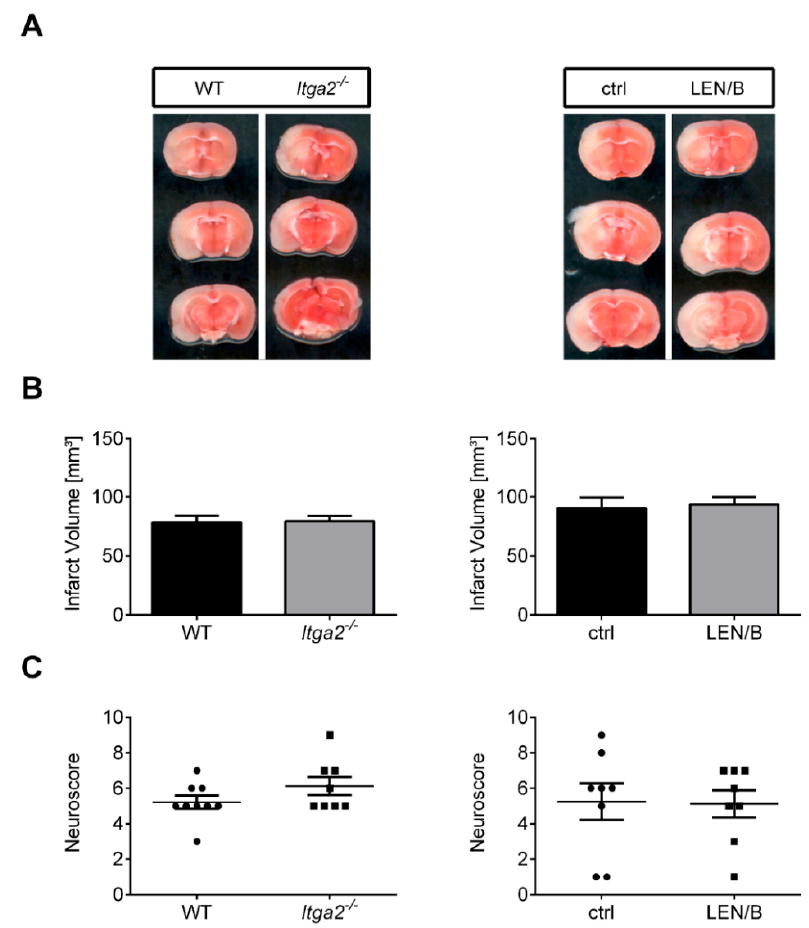
Figure 1. Therapeutic blockade or genetic deficiency of the collagen-binding integrin α 2 β 1 does not alter stroke outcome in a transient middle cerebral artery occlusion (tMCAO) model. ( A ) Representative 2,3,5-triphenyltetrazolium chloride stains of three corresponding brain sections of a wild-type (WT) mouse in comparison to an Itga2 − / − mouse at day 1 after tMCAO ( left ) and a vehicle-treated C57BL / 6 mouse (ctrl) compared to a C57BL / 6 mouse treated with a specific α 2 β 1-antigen binding fragment (LEN / B) 1 h before 60 min tMCAO at day 1 after stroke ( right ). ( B ) Infarct volumes are similar between the two experimental (pharmacologic; transgenic mice) groups (WT, n = 9; Itga2 − / − / ctrl / LEN / B, n = 8 / group; unpaired, two-tailed Student’s t -test). ( C ) Genetic ( left ) or pharmacologic ( right ), α 2 β 1 inhibition does not improve functional outcome on day 1 after tMCAO as assessed by the Neuroscore (Mann–Whitney test).